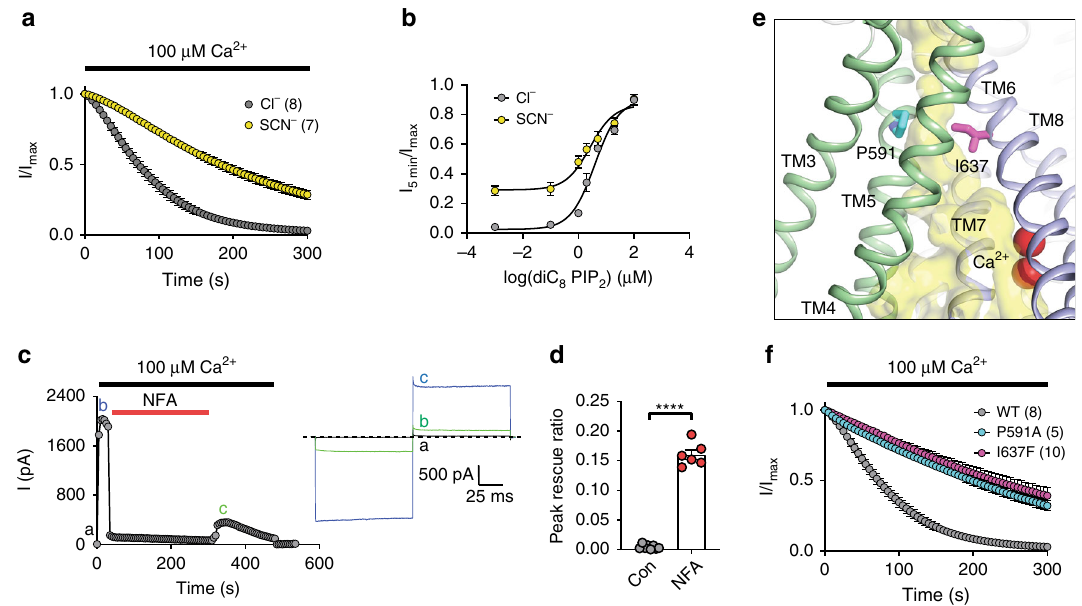
Fig. 6 Disrupting the ion permeation pore alters TMEM16A desensitization. a Average normalized currents of TMEM16A measured in symmetric Cl − or SCN − condition under 100 µ M Ca 2 + . Intracellular and extracellular solutions are symmetric and contain 140 mM Cl − (Cl − ) or 112 mM SCN − /28 mM Cl − (SCN − ). Numbers in parentheses denote the number of individual recordings. b Effects of SCN − on diC 8 PIP 2 dose-response of TMEM16A. n = 6 – 12 for each diC 8 PIP 2 concentration. c , d Representative recording of TMEM16A current in the presence of 300 µ M ni fl unic acid (NFA) and 100 µ M Ca 2 + from intracellular side. Current traces at different time points are shown on the right. Quanti fi cations of peak residual current at 5 min after NFA washout or in control recordings are shown in d . Two-tailed unpaired Student ’ s t -test: p -value is <0.0001. e Side view of mTMEM16A monomer showing the positions of two pore-lining residues P591 (cyan sticks) and I637 (magenta sticks). f Mutational effects of P591A and I637F on TMEM16A desensitization. Numbers in parentheses denote the number of individual recordings. Data are mean ± s.e.m. Source data are provided as a Source Data fi